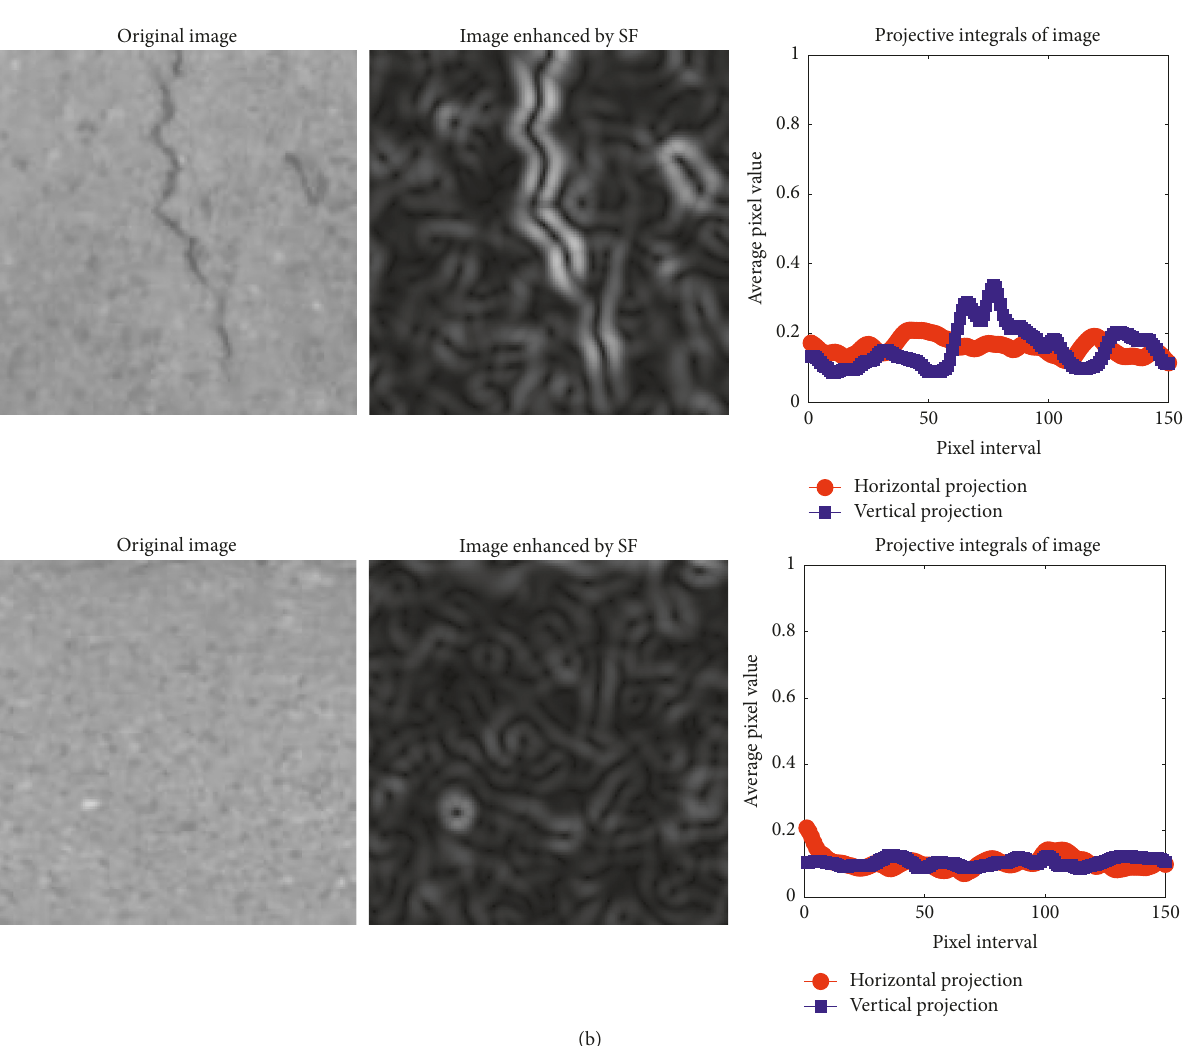
Figure 3: Integral projection of images: (a) pothole class and (b) nonpothole